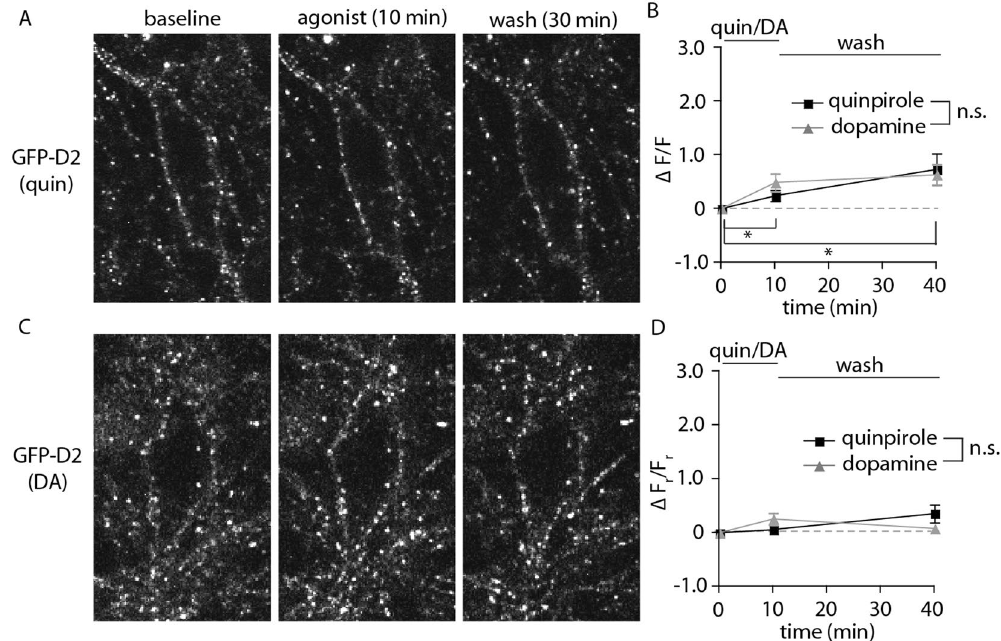
Figure 5. GFP-D2 receptors show limited internalization. ( A, C ) Representative 2-photon images of live neurons at baseline, following 10 minutes of agonist bath application (quinpirole 10 µ M-A, dopamine 100 µ M-C), and following 30 minutes of agonist-free wash. Slices were incubated in anti-GFP-AF594 to label GFP- D2 receptors prior to imaging. ( B ) The change in fluorescence inside the neuron ( Δ F/F) increases modestly but significantly over baseline following the agonist application and wash. There was no difference between the agonists used (n = 6 for both, two-way ANOVA followed by Bonferroni). ( D ) The change in the ratio of intracellular fluorescence to membrane fluorescence ( Δ F r /F r ) did not change significantly from baseline following agonist application or wash (n = 6 for both, two-way ANOVA followed by Bonferroni). * p <